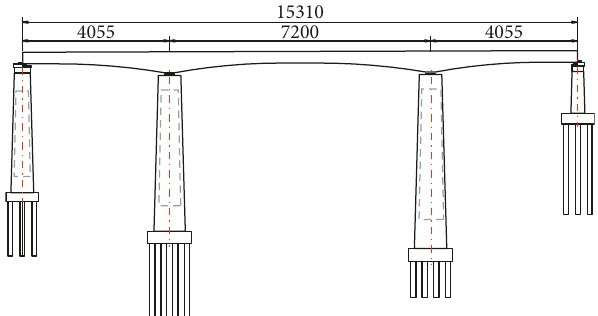
Figure 1: Bridge span arrangement of the prototype (unit: cm).